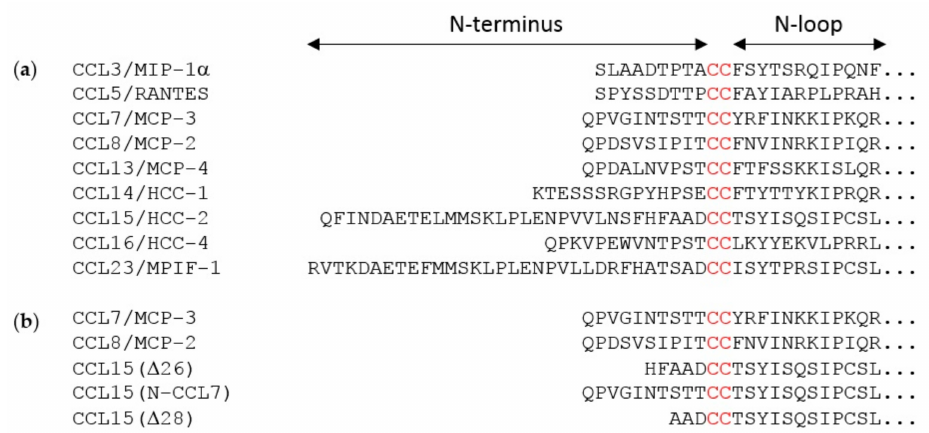
Figure 1. ( a ) Partial sequences of nine cognate chemokine ligands for the receptor CCR1; and ( b ) partial sequences of the chemokines used in this study. The conserved CC motif is in red. The arrows at the top indicate the N-terminal and N-loop regions, which participate in receptor